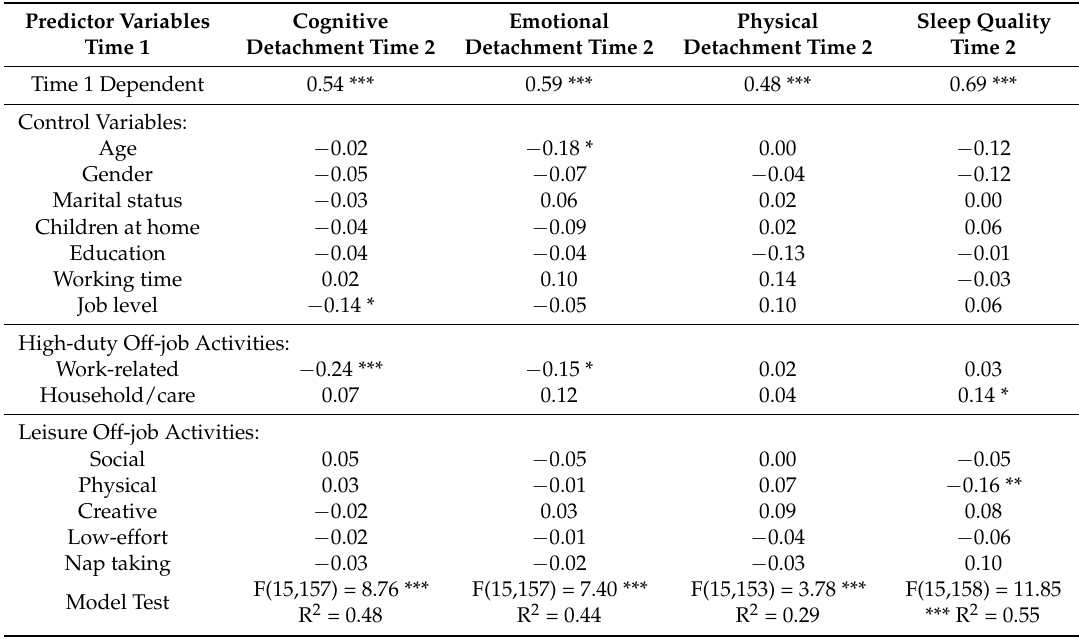
Table 3. Hierarchical regression analyses: Panel results ( n =